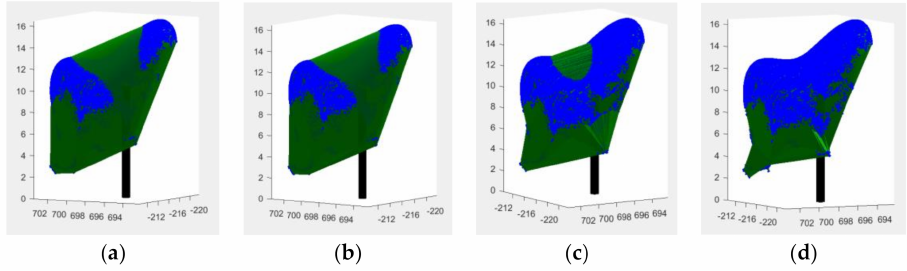
Figure 14. Surface reconstruction results on LiDAR point clouds that have been transformed by spherical harmonics fitting using ( a ) convex hull, ( b ) concave hull, ( c ) alpha shape, and ( d ) robust crust methods.